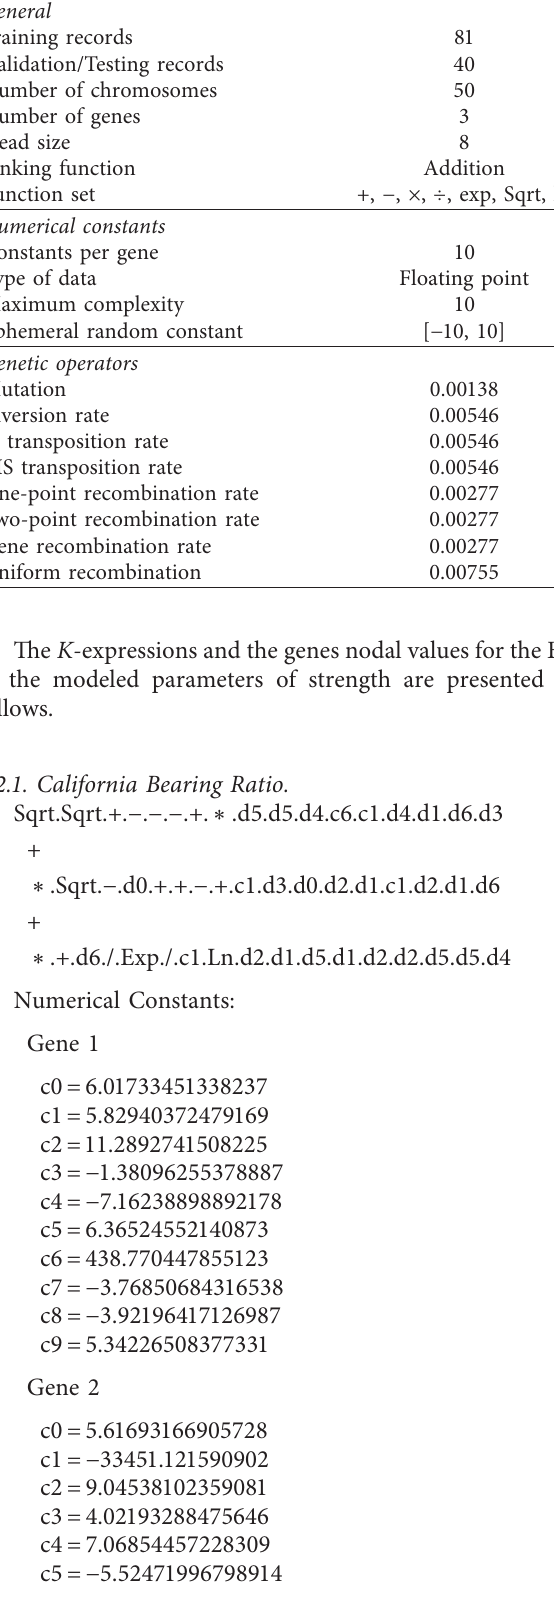
Table 4: Parameters setting for GEP algorithms.